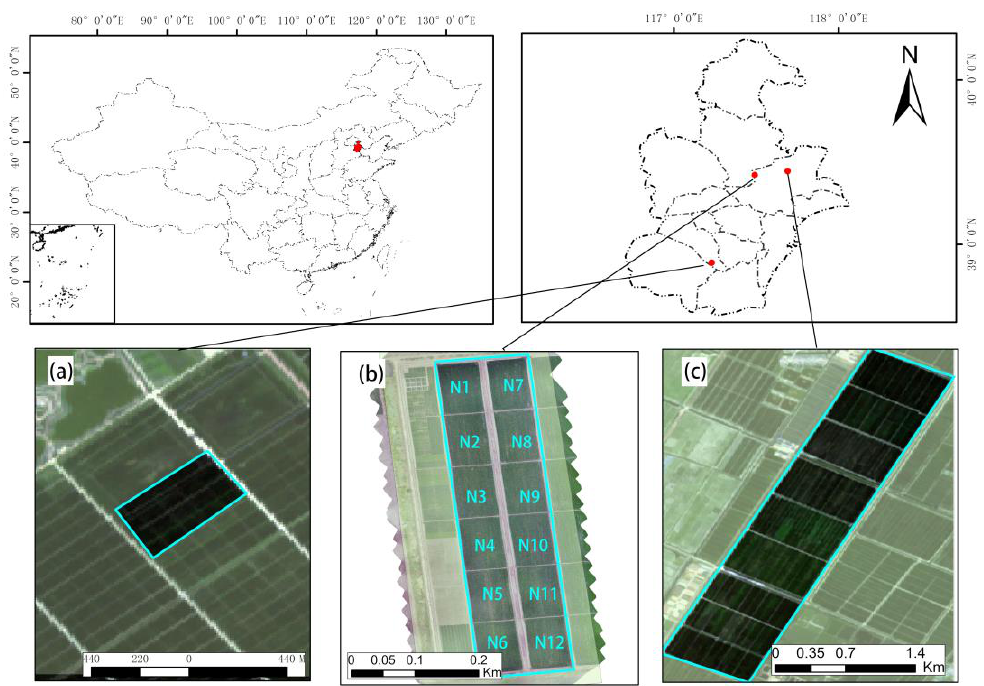
Figure 1. Location of research site ( top ) and image of experimental plots ( bottom ). ( a ) The experimental plot a in the Sinochem Modern Agriculture Tianjin Technical Service Center; ( b ) the experimental plot b in the farm of the Tianjin Ninghe District Quality Agricultural Products Development Demonstration Centre; ( c ) the experimental plot c in the original seed farm of the Tianjin Ninghe District Quality Agricultural Products Development Demonstration Centre.